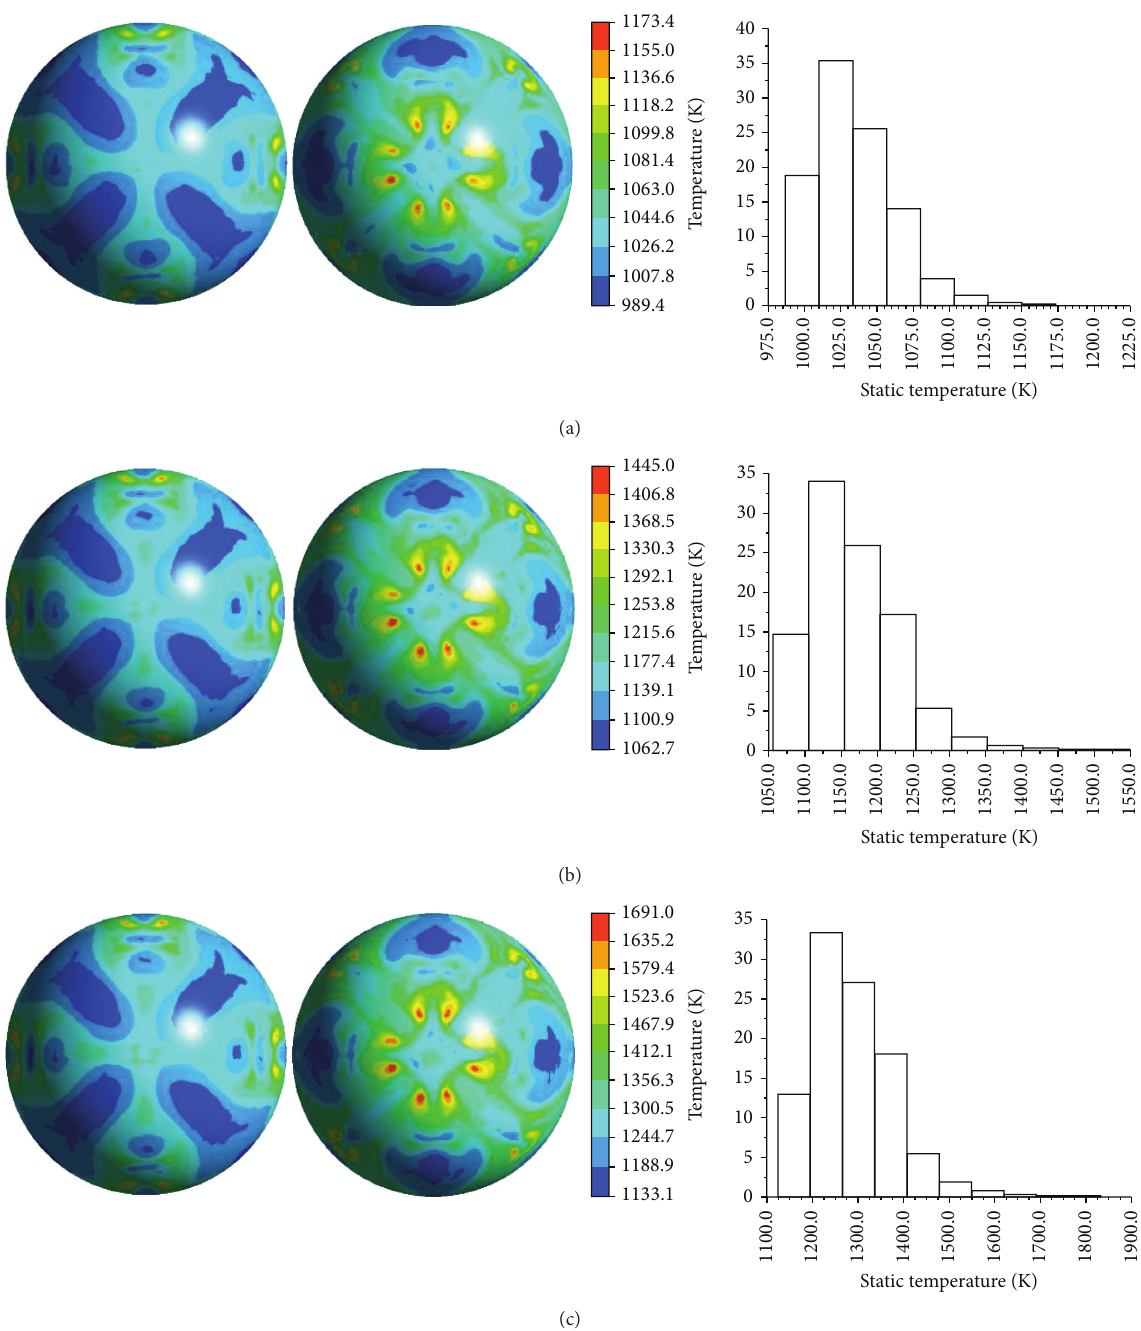
Figure 11: Pebble temperature distribution of FCC model of Cases 2a, 2b, and 2c, (view from inlet (left), outlet (middle)) and temperature distribution